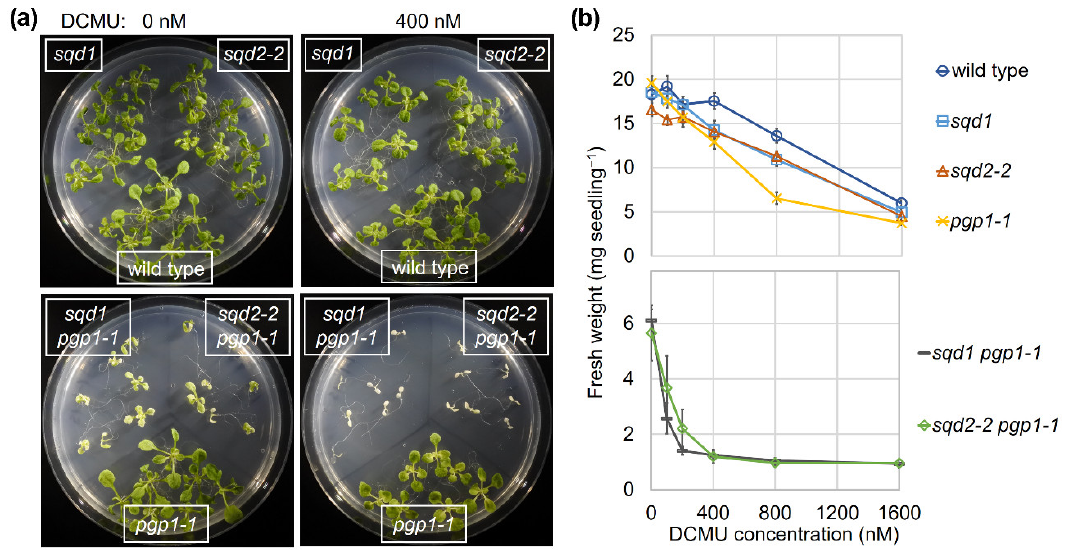
Figure 2. Growth impairment in wild type and anionic lipid mutants by a photosynthesis electron transport inhibitor 3(3,4-dichlorophenyl)-1,1-dimethylurea (DCMU). Seven-d-old seedlings were transferred to DCMU-containing media and grown for another 7 d. ( a ) Growth phenotype of each line in the absence (0 nM) and presence (400 nM) of DCMU. ( b ) Fresh weight of each line under different DCMU concentrations. Data are means ± SE of 14 seedlings for each line from two independent experiments.